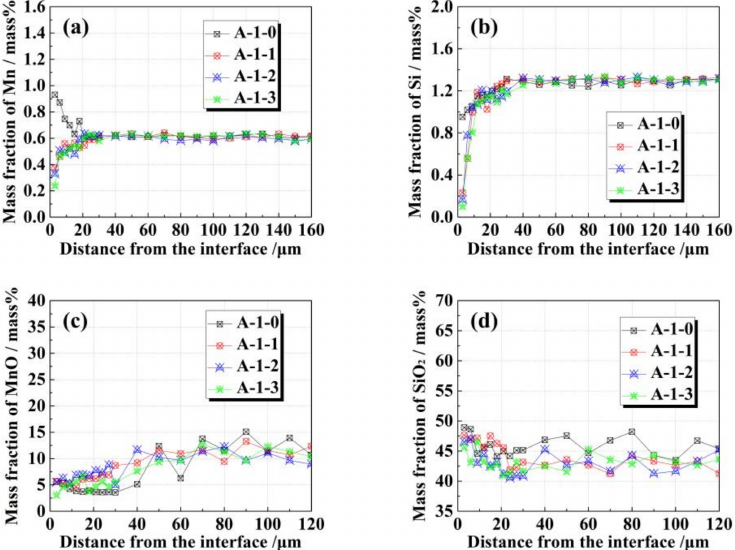
Figure 6. Composition changes in the alloy and oxide near the interface in A-1- x diffusion couples after isothermal heating at 1273 K for 10 h: ( a ) Mn; ( b ) Si; ( c ) MnO; ( d ) SiO 2